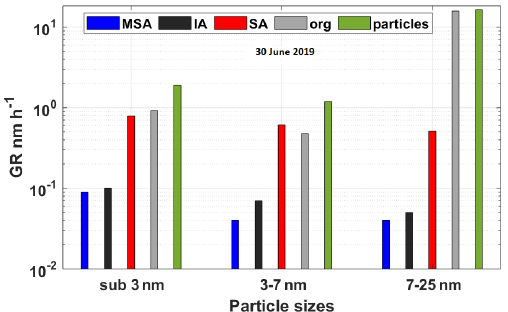
Figure 7. Particle growth rates calculated from the kinetic conden- sation of gases (data from CI–APi–TOF; org: organic) and the mea- sured particle GRs (data from the NAIS) in different size classes on 30 June